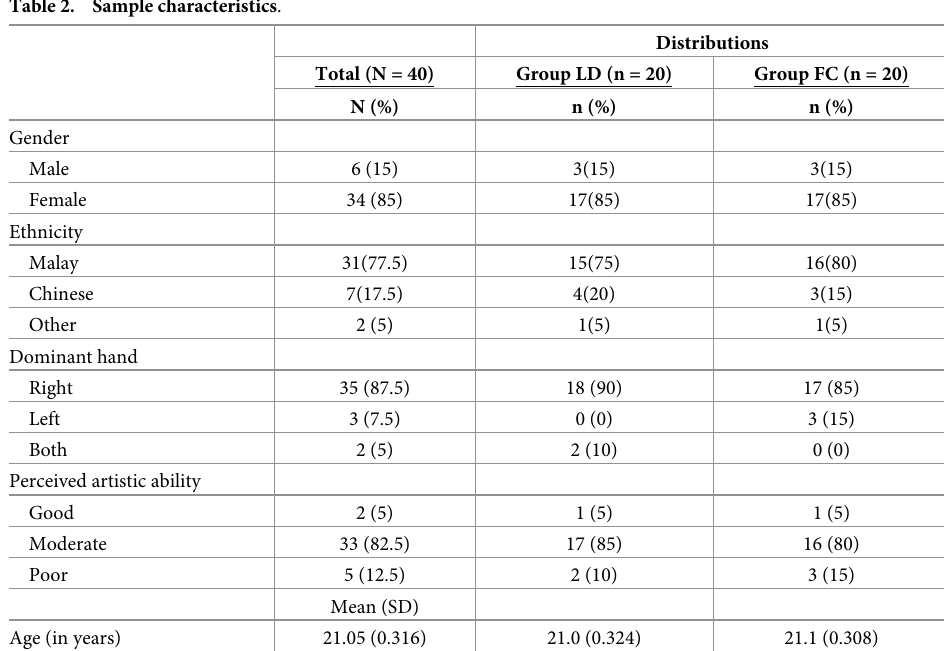
Table 2. Sample characteristics .